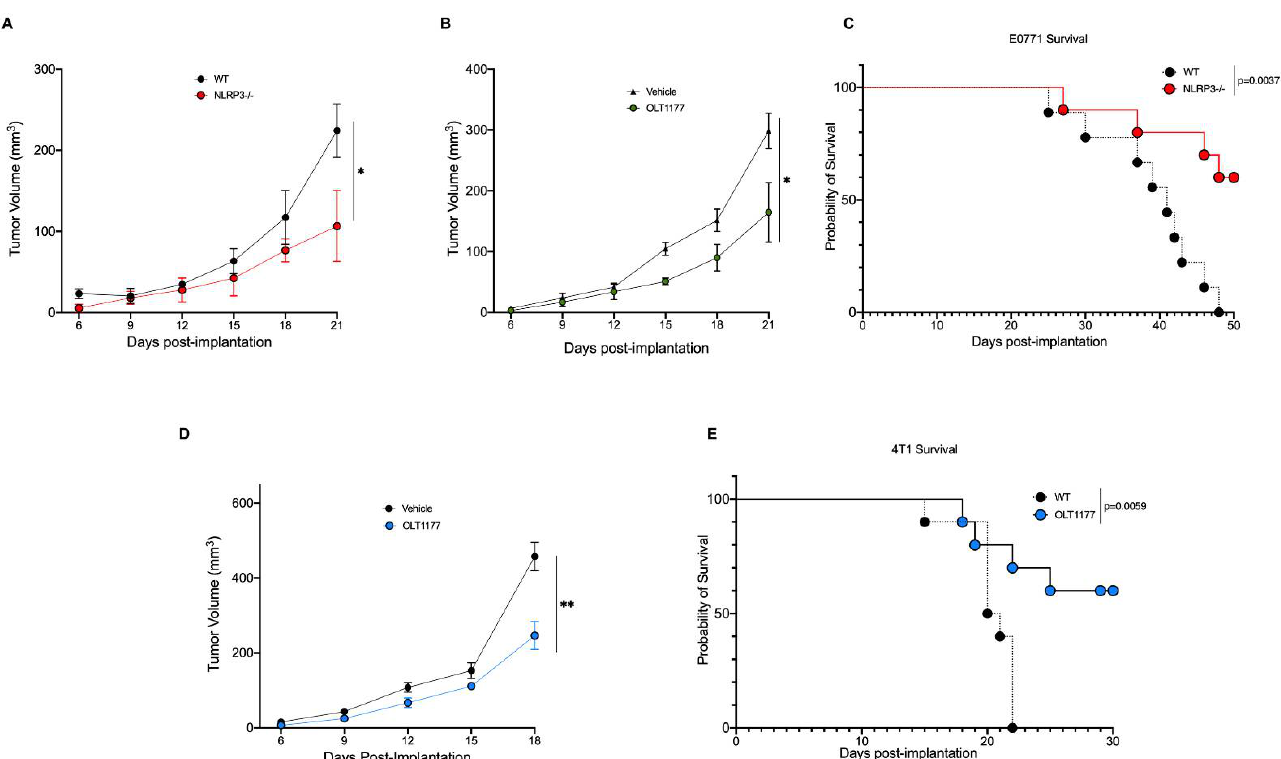
Figure 1. Genetic and pharmacologic inhibition of NLRP3 reduces breast cancer progression. ( A